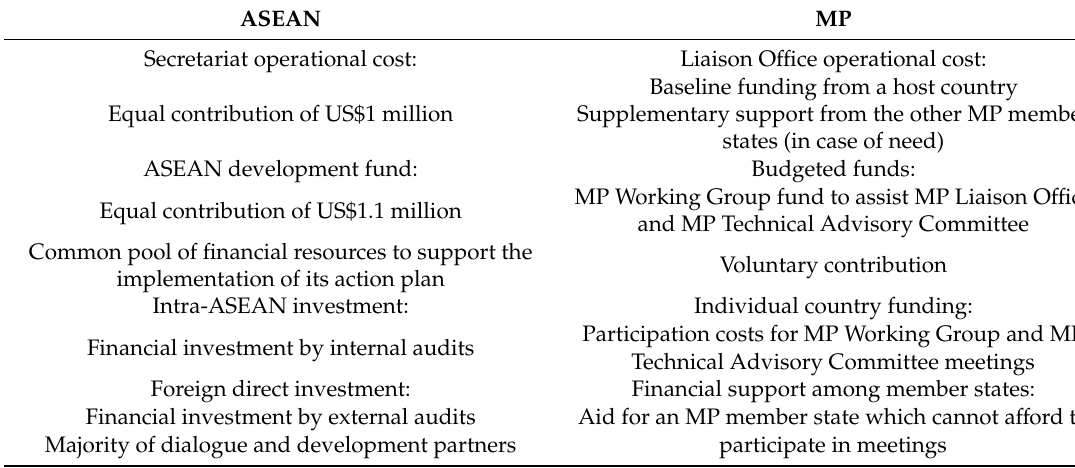
Table 3. ASEAN and MP financing systems adapted from